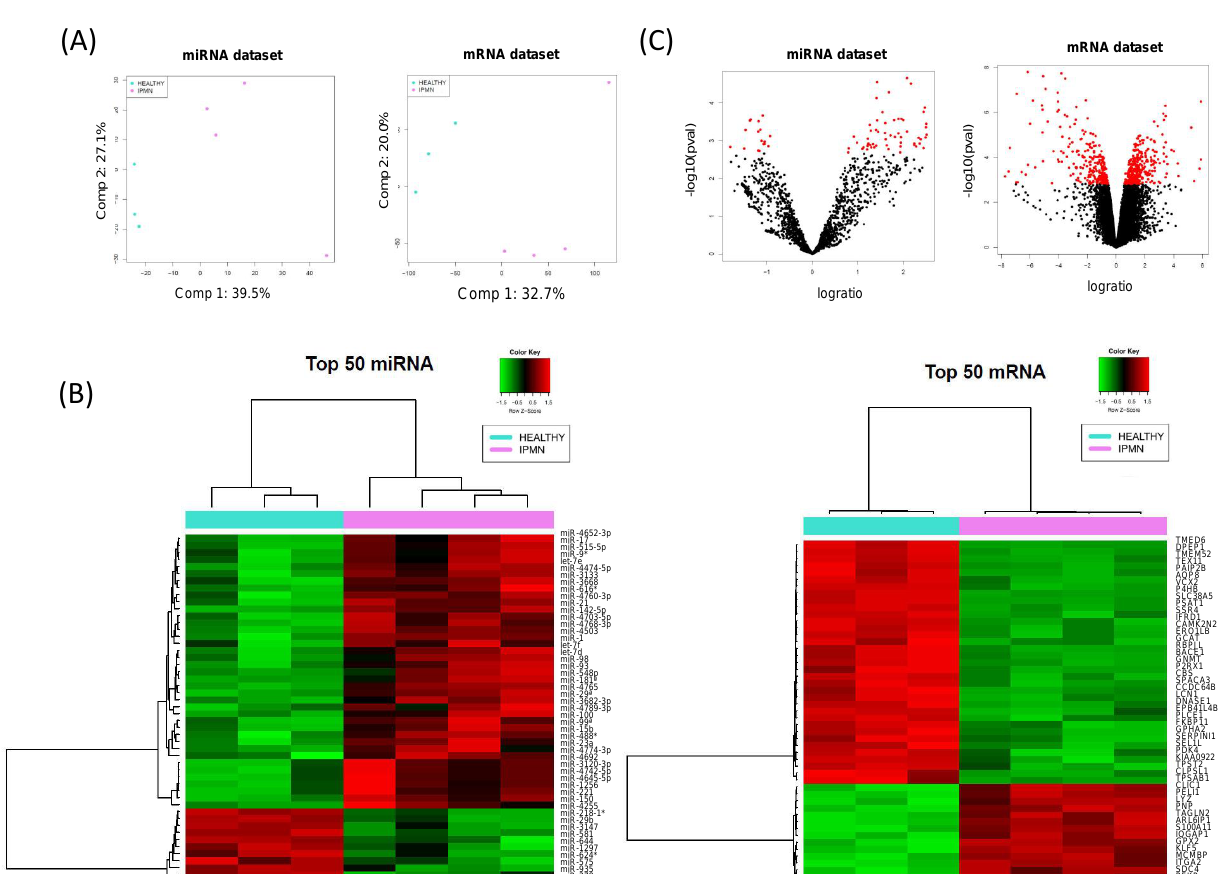
Figure 1. Paired miRNA and mRNA expression data in IPMN. ( A ) Principal Components Analysis plot representation of correlation matrix for miRNA (left) and mRNA (right) expression data in Healthy ( n = 3) and IPMN ( n = 4) pancreatic tissue samples. ( B ) Heatmaps of the top 50 differentially expressed miRNAs (left) and mRNAs (right) sorted by absolute FC value (FDR < 0.05). ( C ) The volcano plot of expression data for miRNAs (left) and mRNAs (right), red dots highlight for FDR < 0.05 and absolute FC >